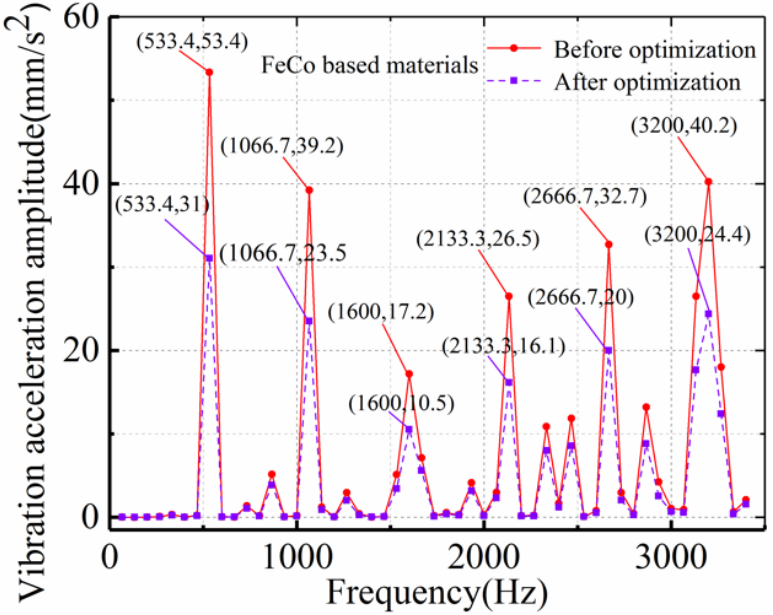
Figure 6. Comparison curve of vibration acceleration frequency spectrum of different materials.